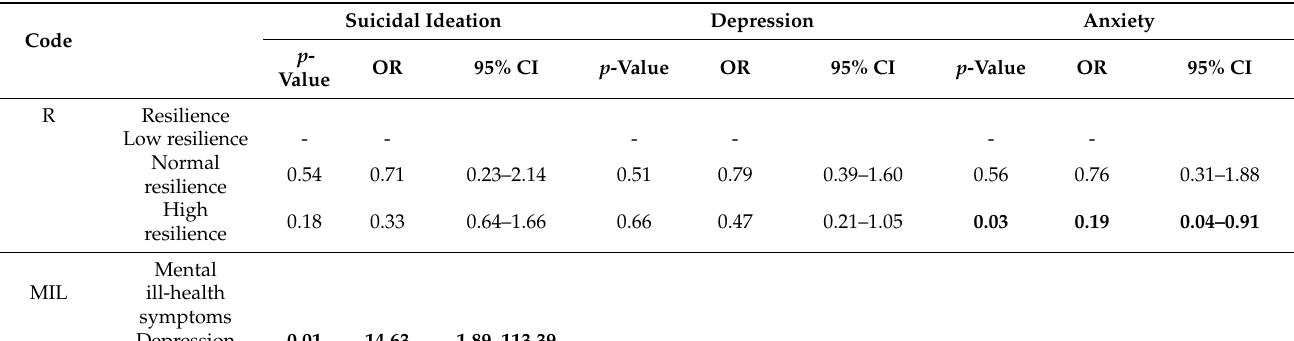
Table 3. Univariate logistic regression estimating the odds ratios for poor mental health and suicidal ideation in relation to resilience level, suicidal ideation versus depression and